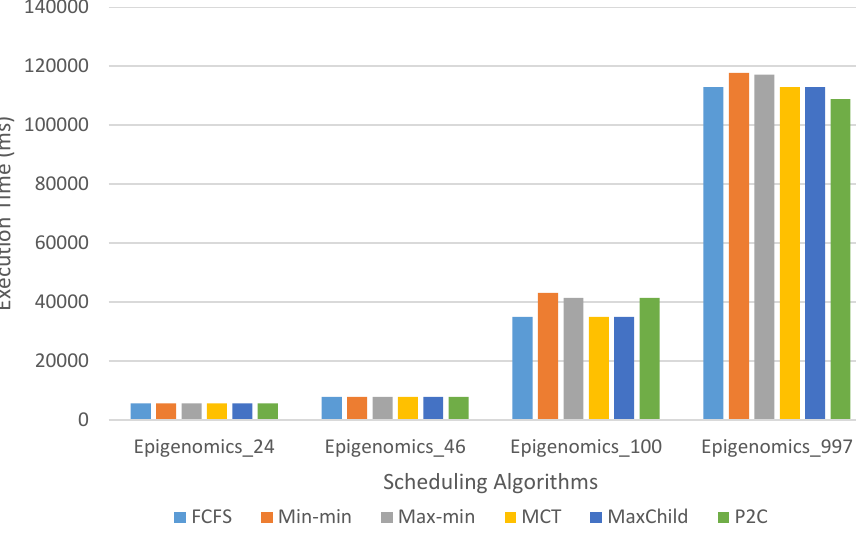
Figure 14. Comparison of execution time for epigenomics